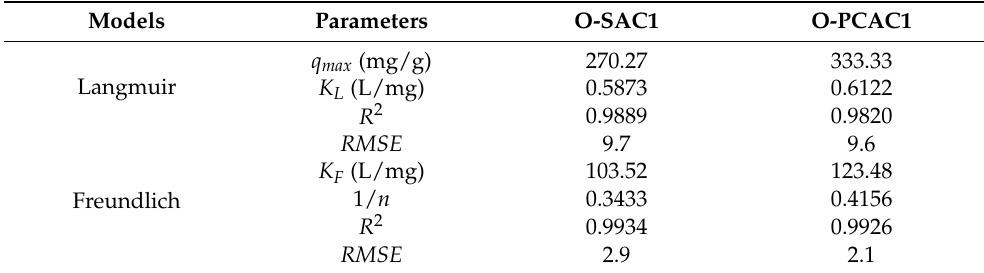
Table 5. Adsorption capacities of adsorbents.